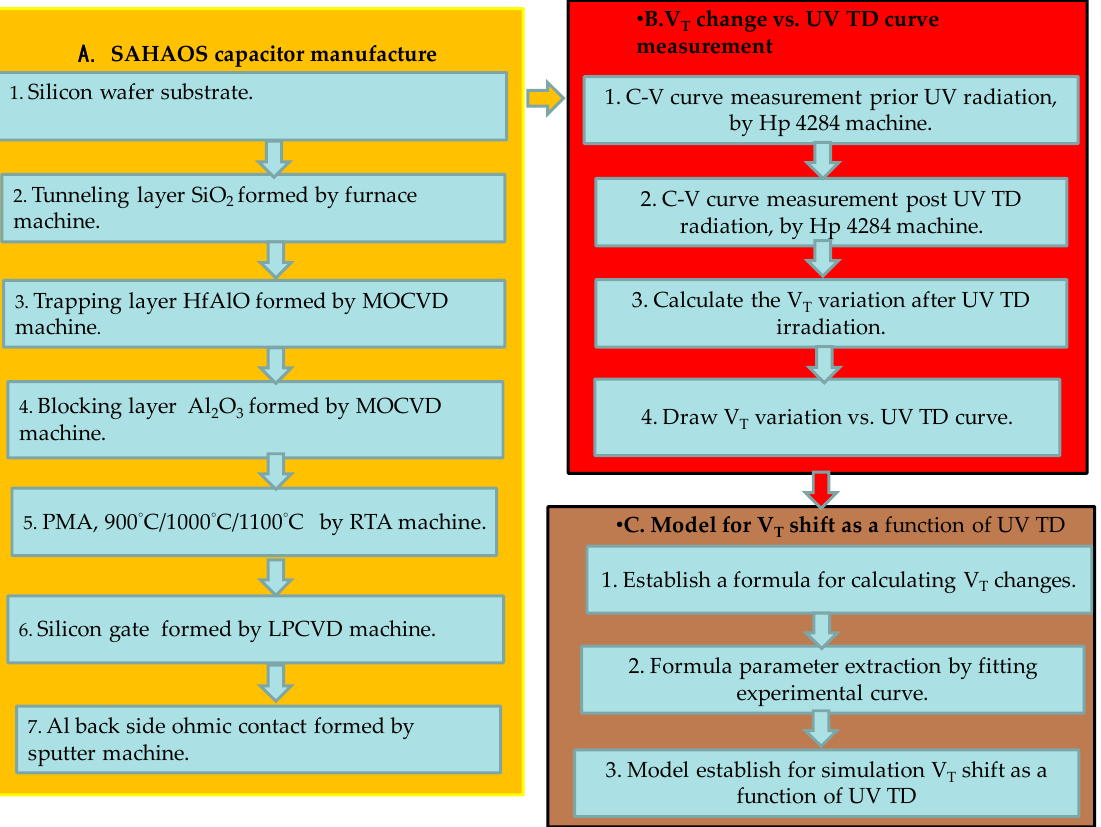
Figure 2. Experimental and simulation approach.